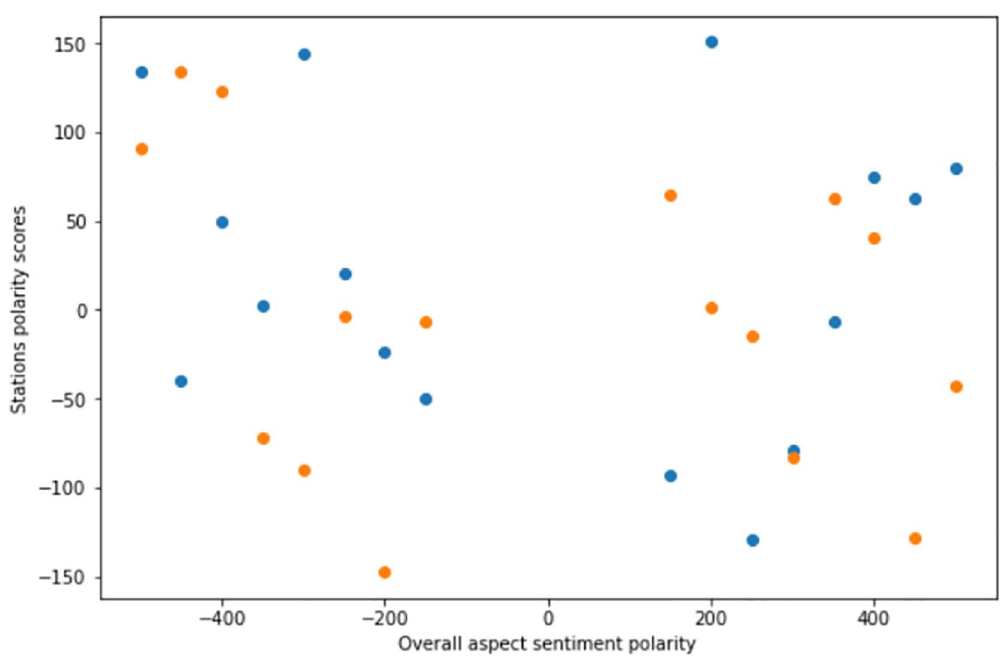
Fig 23. Two dimensions (station-polarity) graph embedding.